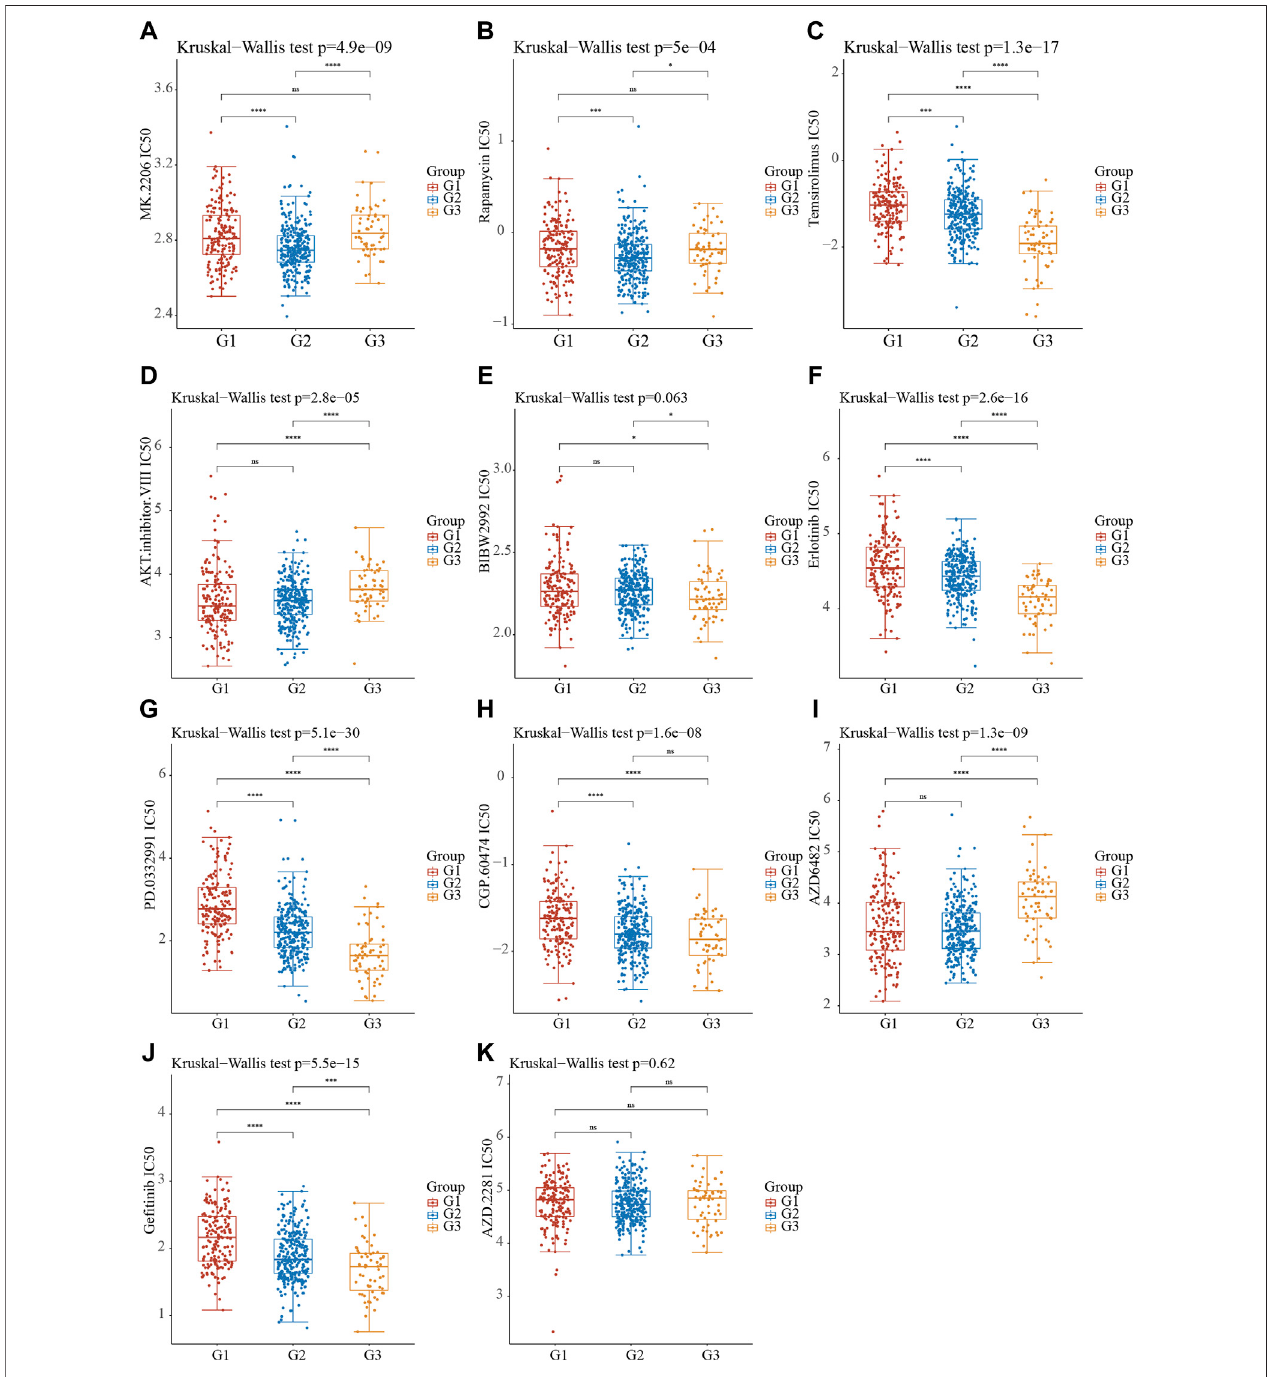
FIGURE7| TheMolecularSubtypesofStressGranuleRegulatorsPredictDrugResponseinNon-SmallCellLungCancer. (A – K) StressGranuleRegulatorsbased subtypes predicted the response to MK.2206 (AKT.inhibitor) (A) , Rapamycin (mTOR inhibitor) (B) , Temsirolimus (PI3K/MTOR signaling) (C) , AKT.inhibitor (D) , BIBW2992(EGFR signaling) (E) ,Erlotinib(EGFRsignaling) (F) ,PD.0332991(CDK4/6 inhibitor) (G) ,CGP.60474 (CDKinhibitor)(H),AZD6482 (PI3Kinhibitor) (I) ,Ge fi tinib (EGFR signaling) (J) and AZD2281 (K) in NSCLC.